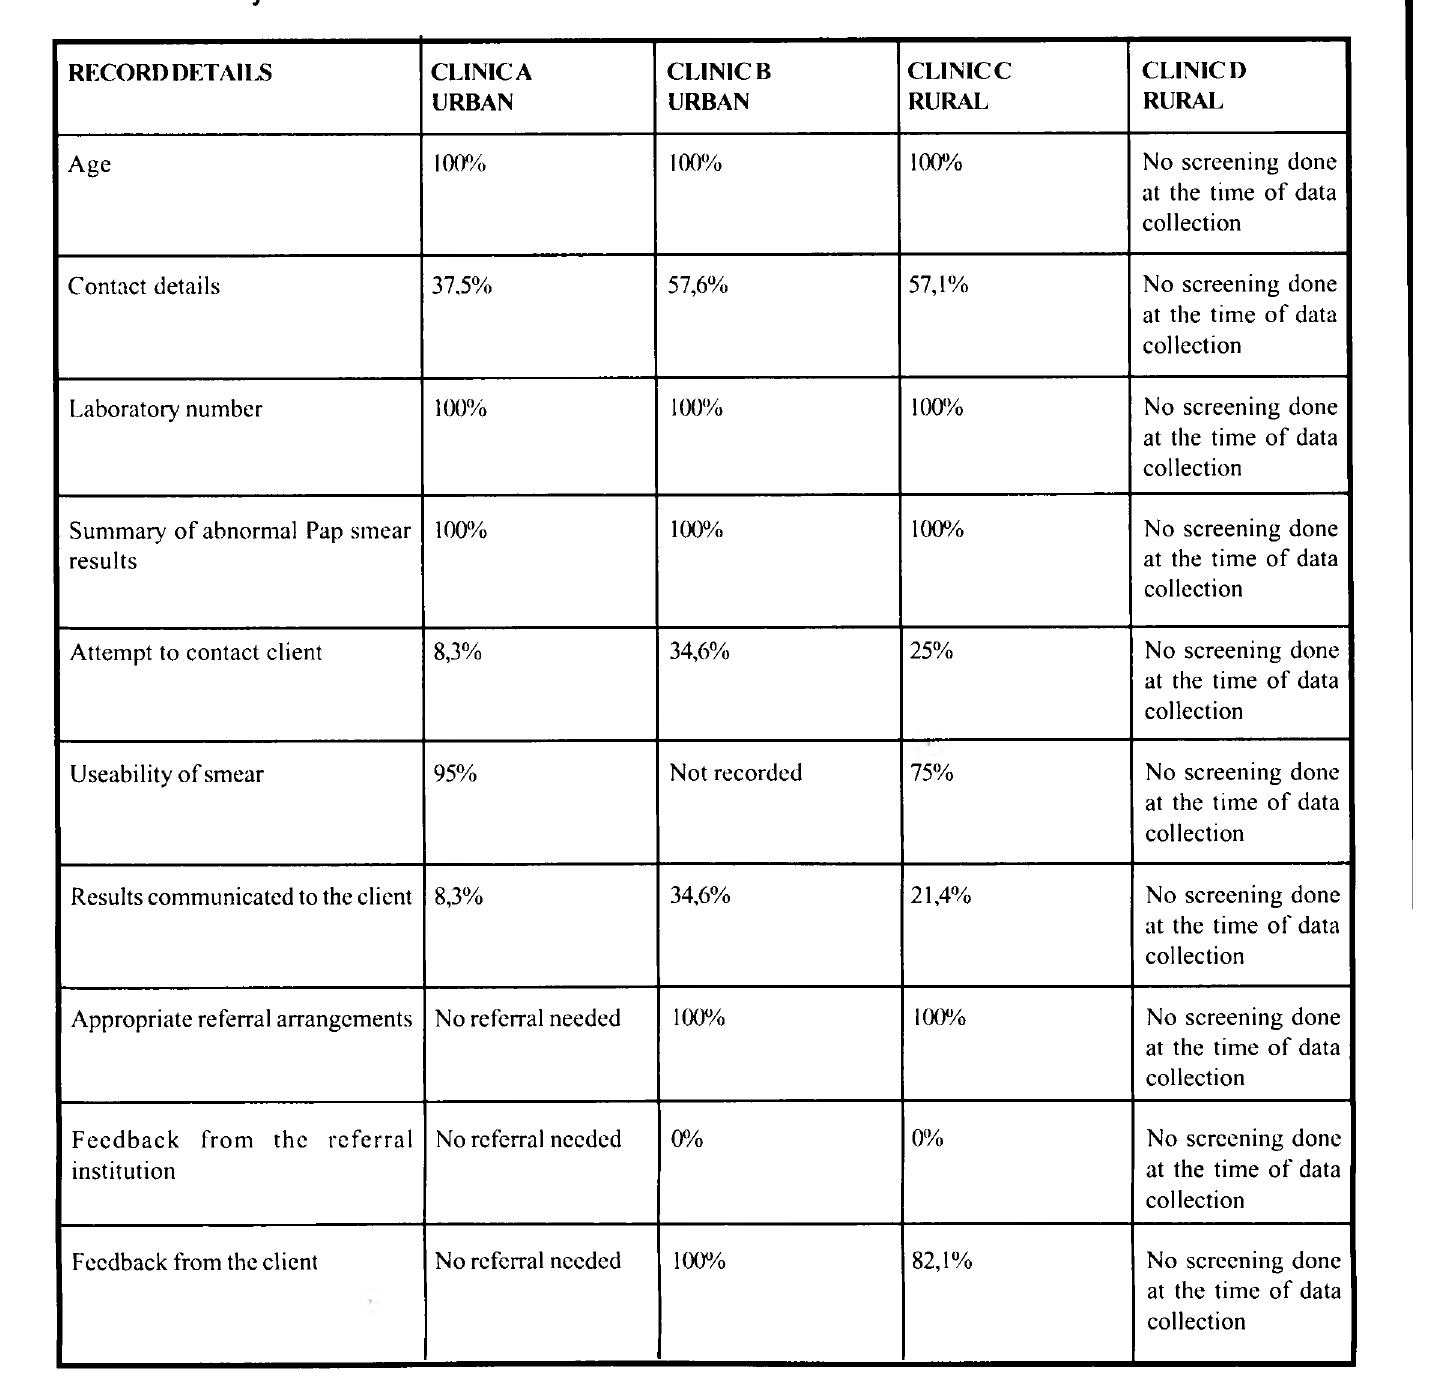
Table 2: Summary of record review RECORD